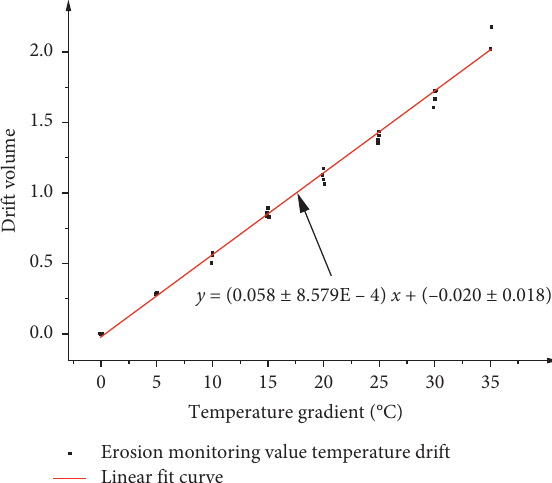
Figure 11: Temperature drift and linear fitting